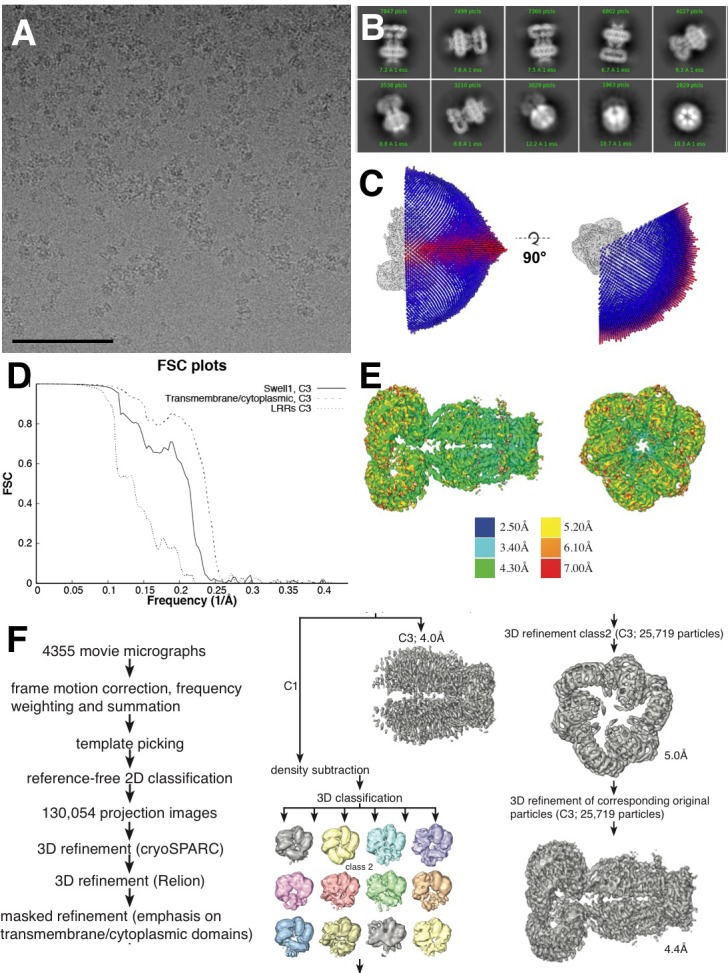
Cryo-EM data collection.(A) Representative aligned micrograph (scale bar, 100 µm). 4355 movies were collected of SWELL1-FLAG in vitreous ice. (B) Representative 2D classes showing range of orientations of SWELL1-FLAG particles. (C) Euler distribution for final map. Applied C3 symmetry was used, thus only one third of the sphere is shown. (D) Fourier shell correlation between two independently refined cryo-data half sets. (E) Local resolution estimates of the final reconstruction. (F) Data-processing flow chart.